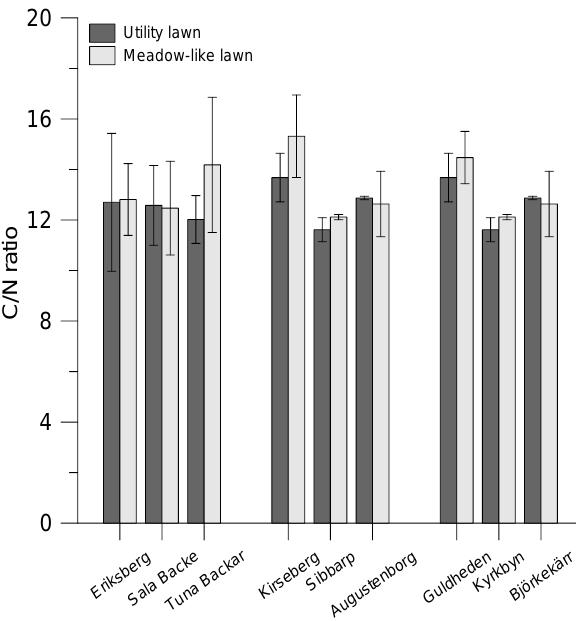
Figure 6. Bar plot showing measured C:N ratio of the two different lawn types at each site. Error bars indicate standard